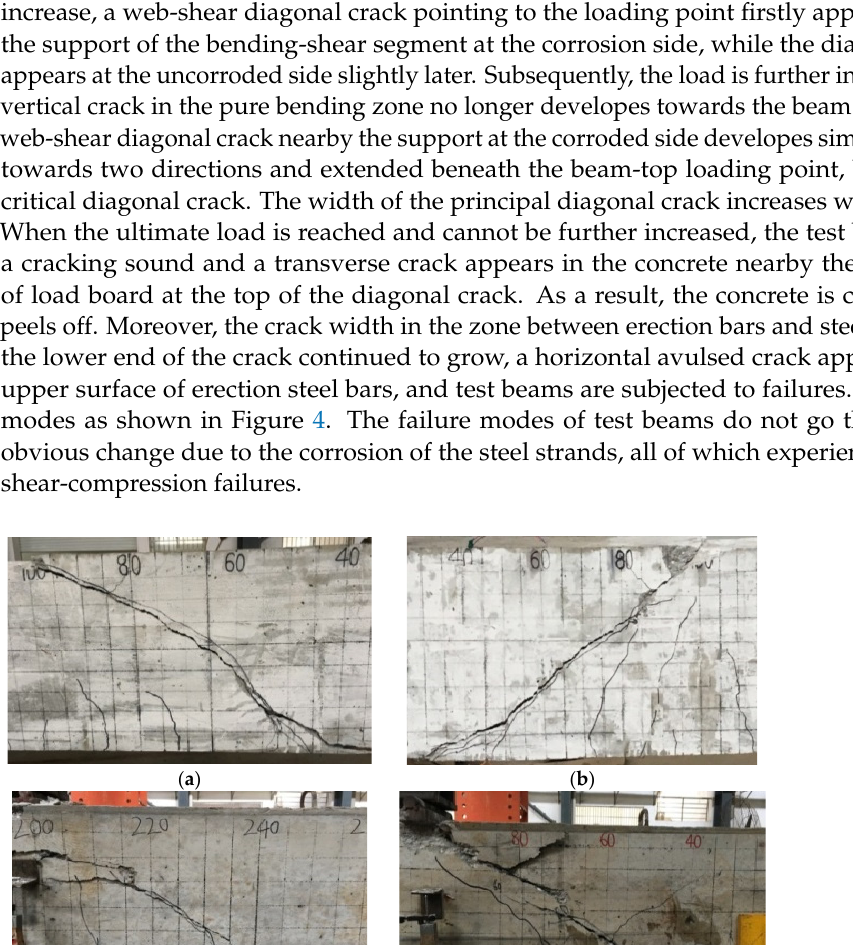
Figure 5. Load–midspan deflection curves. In the initial loading stage, the midspan deflection of each test beam is basically linearly correlated with the load and showed elastic structural characteristics, and the deflection difference is very minor. This is because each test beam is in an elastic defor- mation stage, and the structural stiffness is mainly controlled by concrete. At this time, the structure is not crack yet, and the overall stiffness difference is not large. After the load reaches the cracking load, the slope of the load-deflection curve of each test beam declines. The growth rate of deflection is higher than that of the load, and the structure is inelastic, indicating that the structural stiffness declines due to cracking. However, the stiffness decrements of different test beams are inconsistent. The load–deflection curves 04080120160200 240280320 0